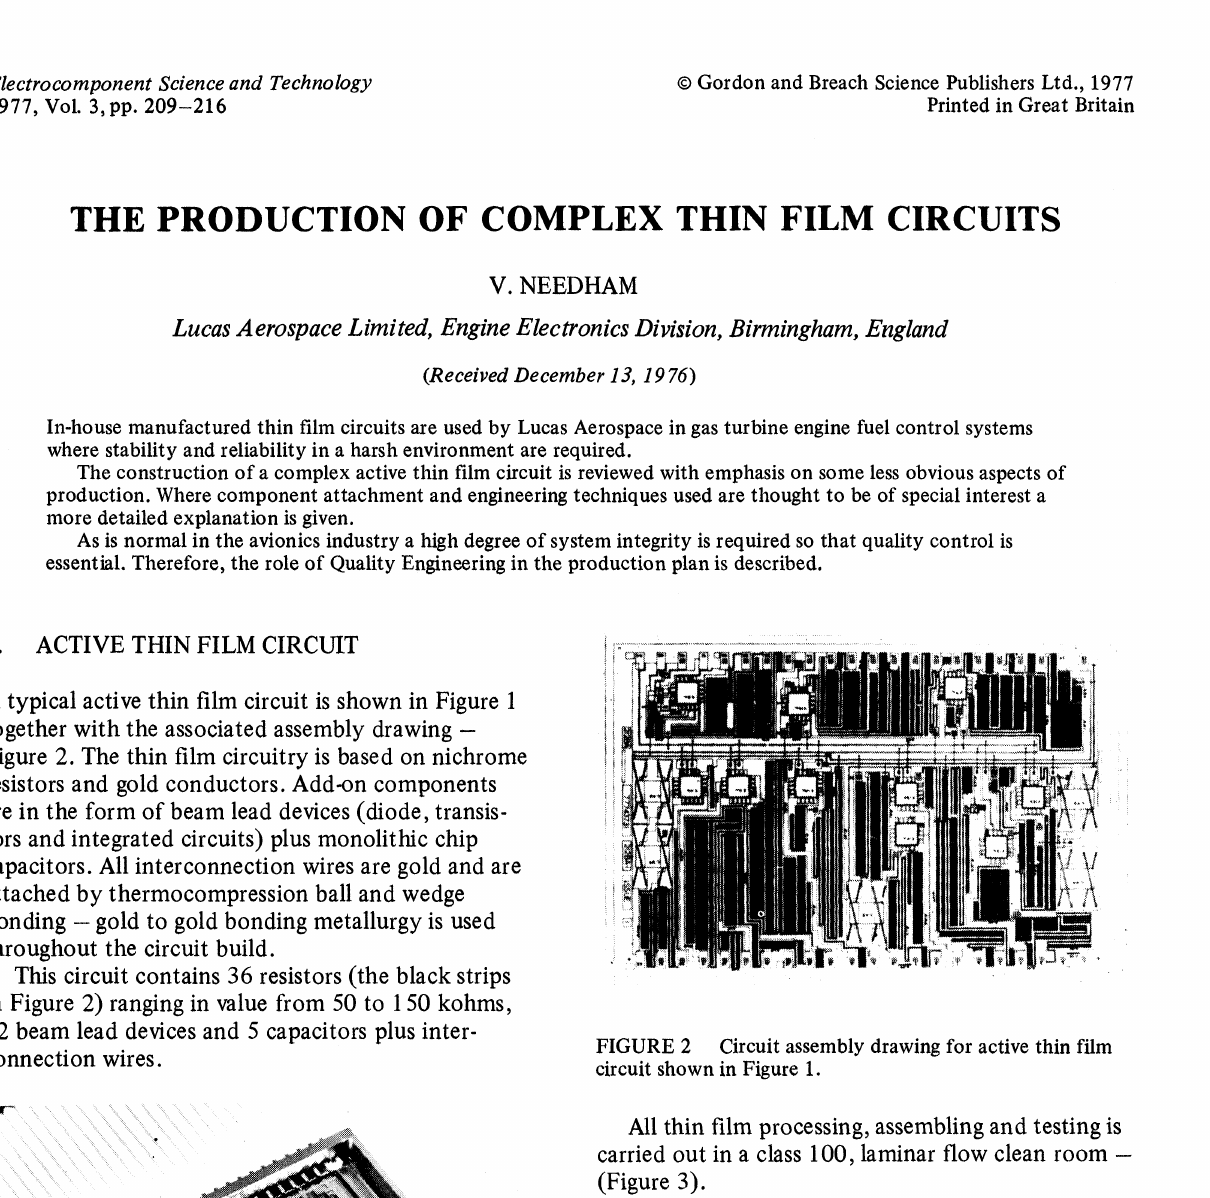
FIGURE 2 Circuit assembly drawing for active thin film circuit shown in Figure 1. All thin film processing, assembling and testing is carried out in a class 100, laminar flow clean room (Figure 3).